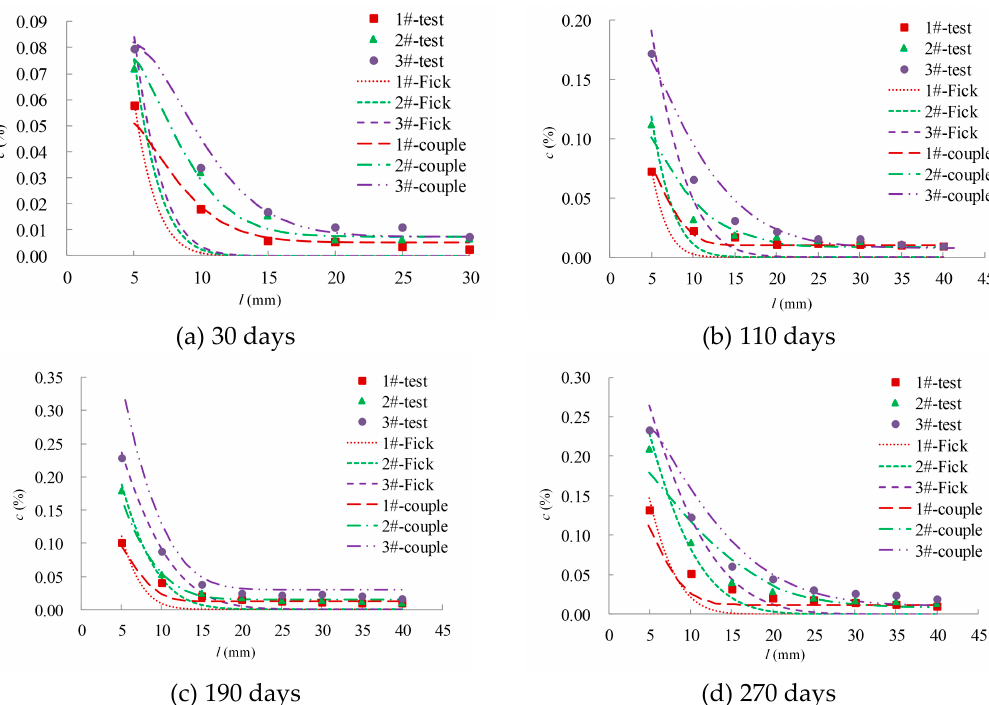
Figure 10. The comparison curves of chloride ion concentration, c , with depth, l.